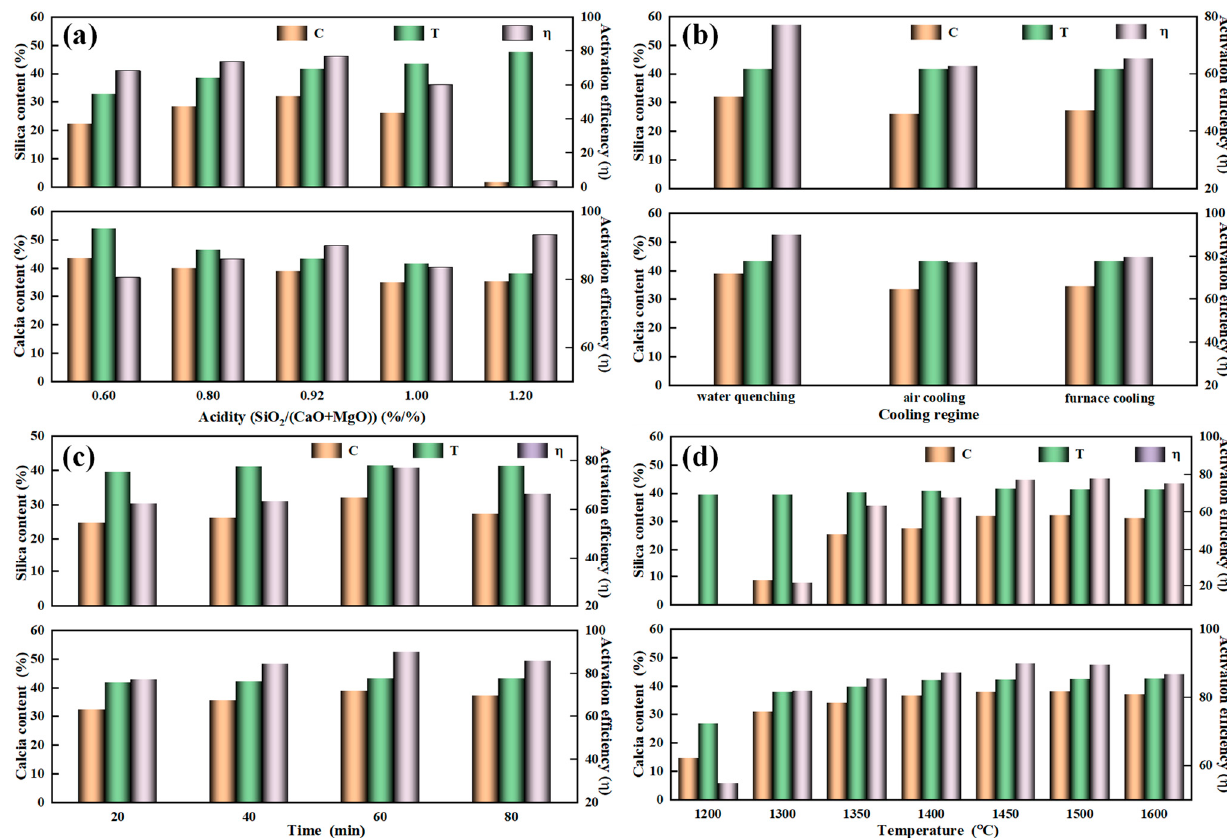
Figure 7. Nutrient activities of the slag obtained under different conditions. ( a ) Smelting at 1450 °C for 60 min under different acidity; ( b ) Smelting at 1450 °C for 60 min with an acidity of 0.92 under different cooling methods; ( c ) Smelting at 1450 °C with an acidity of 0.92 under different reaction time; ( d ) Smelting for 60 min with an acidity of 0.92 under different reaction temperature.